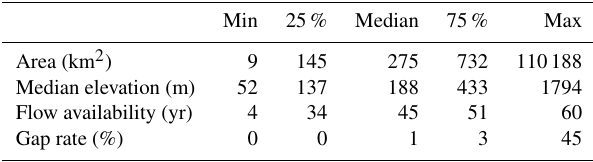
Table 1. Summary of the main characteristics of the 118 catch-